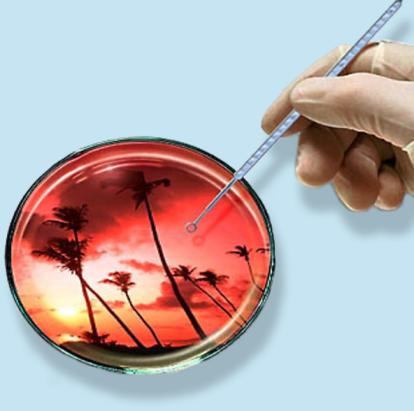
International Travel May Contribute to the Spread of Infectious Diseases across Borders